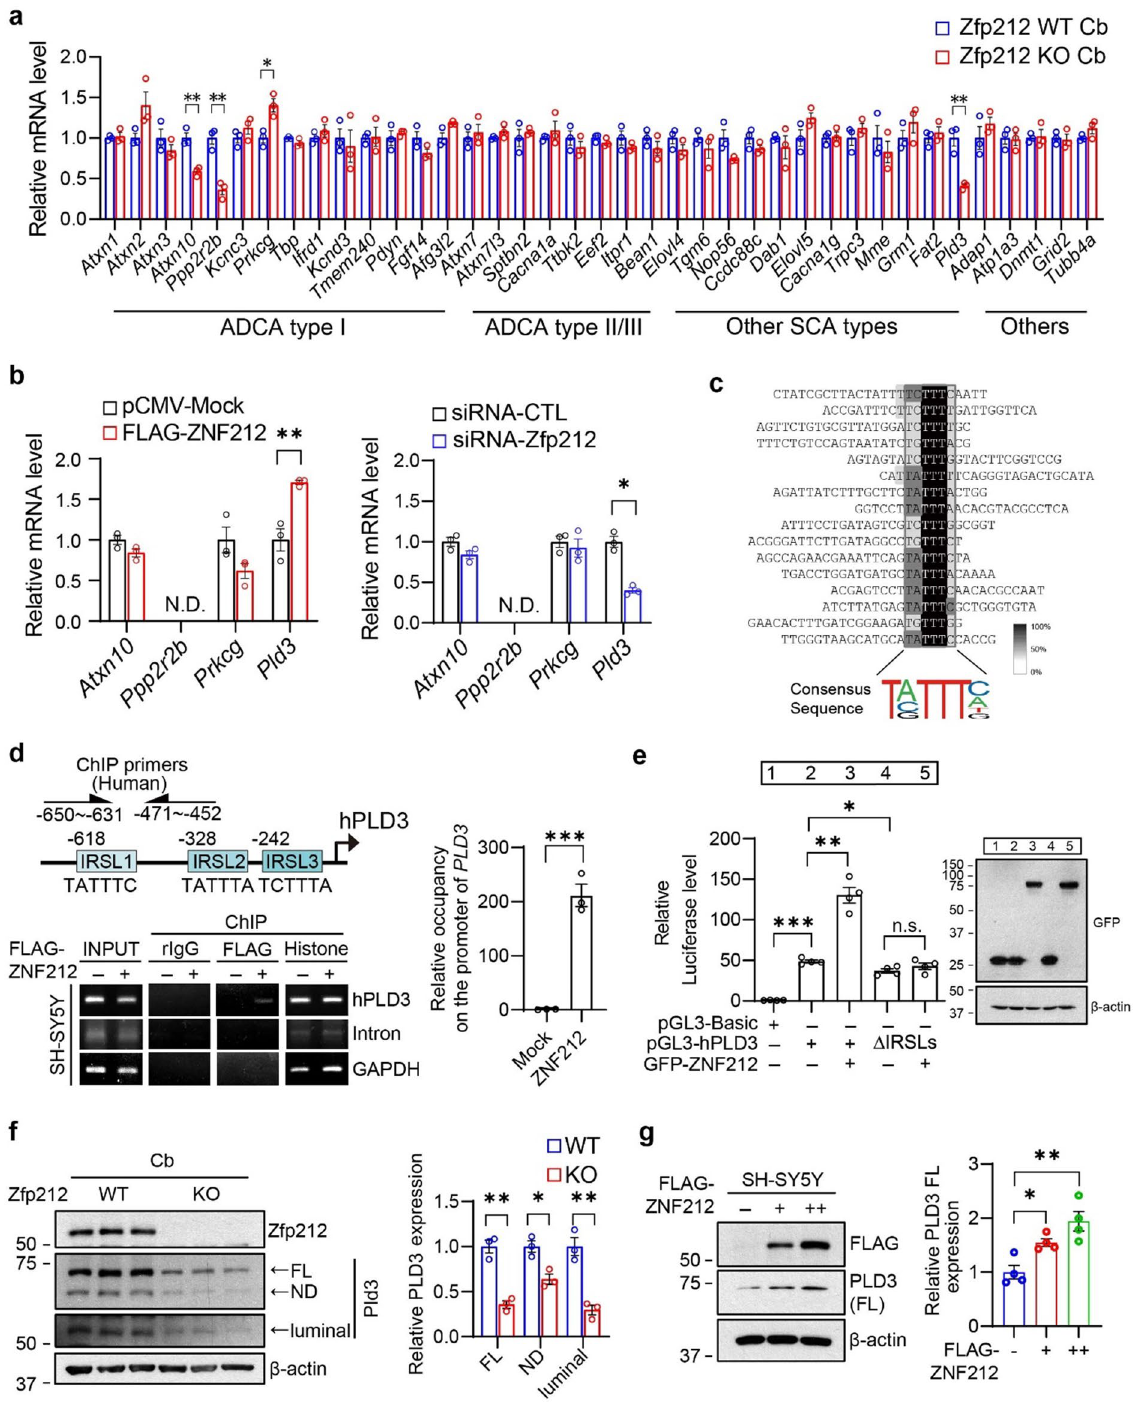
Figure 4. ZNF212 regulates PLD3 by binding to the insulin responsive sequence-like motif. ( a ) RT-qPCR analysis of 39 cerebellar ataxia-related genes in the cerebellum of 3-month-old Zfp212-WT and -KO mice. Relative mRNA levels were normalized to reference genes, Rpl32 ( n = 3). ( b ) mRNA levels of Atxn10 , Pp2r2b , Prkcg , and Pld3 in HT22 cells transfected with Flag-tagged ZNF212 or siRNA-Zfp212 ( n = 3). N.D., not detected. ( c ) CAST analysis with GST-tagged ZNF212, identifying IRSL (insulin responsive sequence- like) motif as a DNA binding site of ZNF212. Sixteen ZNF212-bound DNA probes were sequenced and aligned with the Multiple Alignment Construction and Analysis Workbench (MACAW 2.05, https:// www. en. bio- soft. net/ format/ MACAW. html) software. ( d ) Schematic image of human PLD3 promoter containing IRSLs. ChIP assay with SH-SY5Y cells overexpressing Flag-tagged ZNF212 Rabbit IgG (rIgG) and histone antibodies used as negative and positive controls, respectively. Three replicated experiments were quantified with quantitative real-time PCR. ChIP elute was normalized with input. ( e ) Luciferase promoter assay with SH-SY5Y cells transfected with the human PLD3 promoter and GFP-tagged ZNF212. Transfection efficacy was confirmed by immunoblot analysis. n.s., not significant. ( f ) Immunoblot of Zfp212 and Pld3 in the cerebellum of 8-week-old Zfp212-WT and KO mice. Three forms of Pld3 were annotated using full-length (FL), N-terminal deletion (ND), and luminal Pld3. Pld3 expression was quantified (right panel, n = 3). ( g ) ZNF212 activated PLD3 in a dose-dependent manner. Quantification of PLD3 proteins in the right panel ( n =